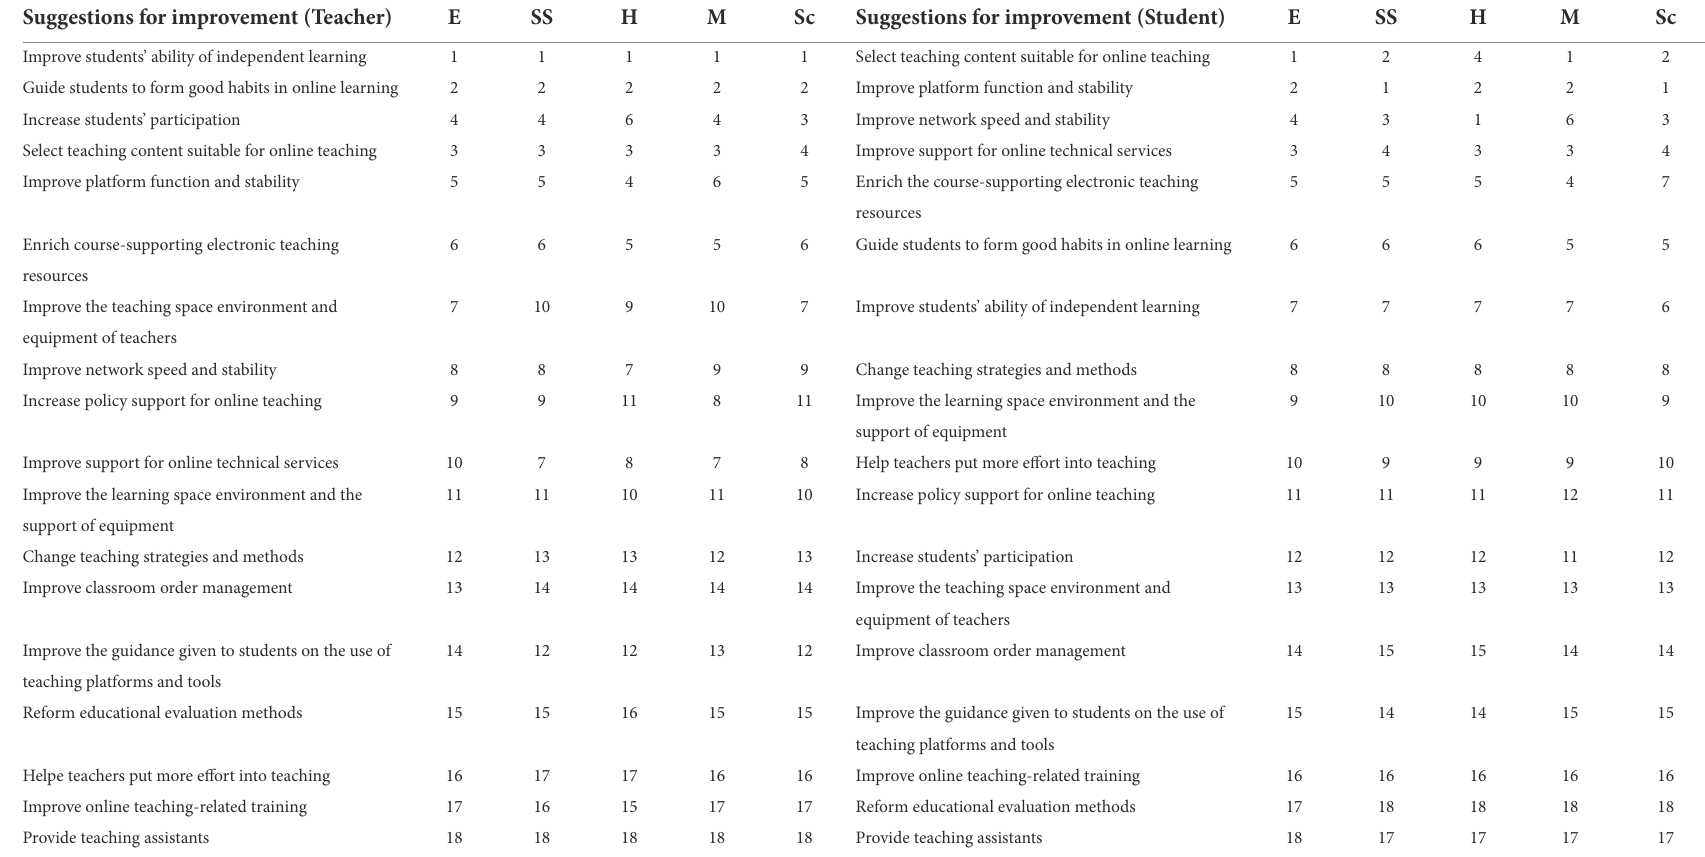
TABLE 5 Evaluation of suggestions for the improvement of online education by teachers and students of different disciplines. Suggestions for improvement